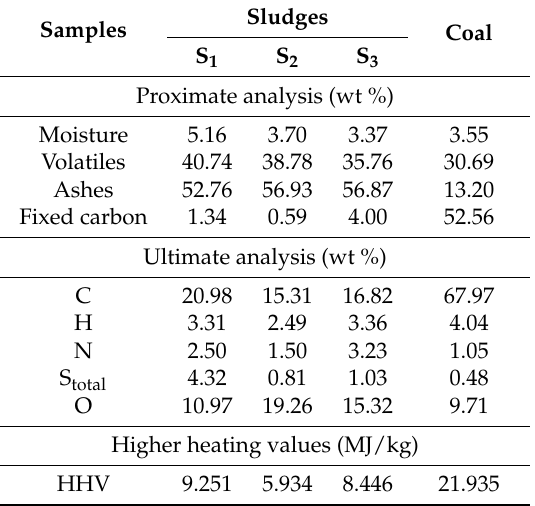
Table 1. Proximate, ultimate analysis results, and higher heating values of the samples.